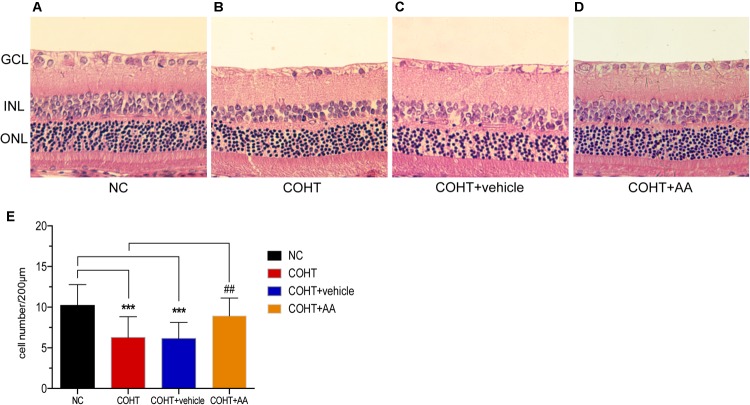
Histological differences observed across NC, COHT, COHT+vehicle, and COHT+AA groups at 2 weeks. (A–D) Representative images of H&E-stained retinal cross-sections from the NC, COHT, COHT+vehicle, and COHT+AA groups (n = 6 per group). Scale bar: 25 μm. (E) Quantification of the number of cells in the GCL. Data are presented as mean ± SD, ##p < 0.01, ###p < 0.001, compared to the COHT group; ∗∗∗p < 0.001, compared to the NC group (n = 6 per group). GCL, ganglion cell layer; INL, inner nuclear layer; ONL, outer nuclear layer.